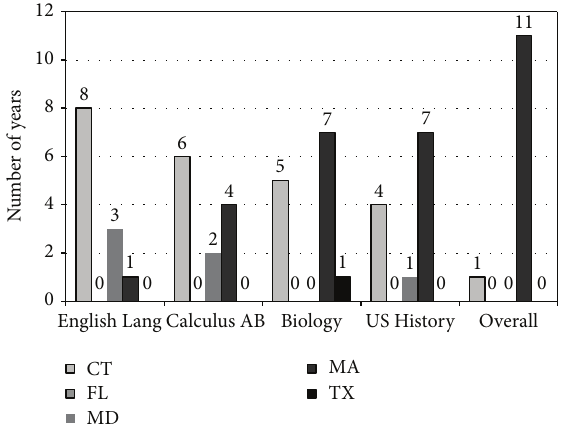
Figure 1: A summary of the number of years in which Black male students in Connecticut, Florida, Maryland, Massachusetts, and Texas achieved the highest percentage of students who earned an AP exam of 4 or 5 between 2001 and